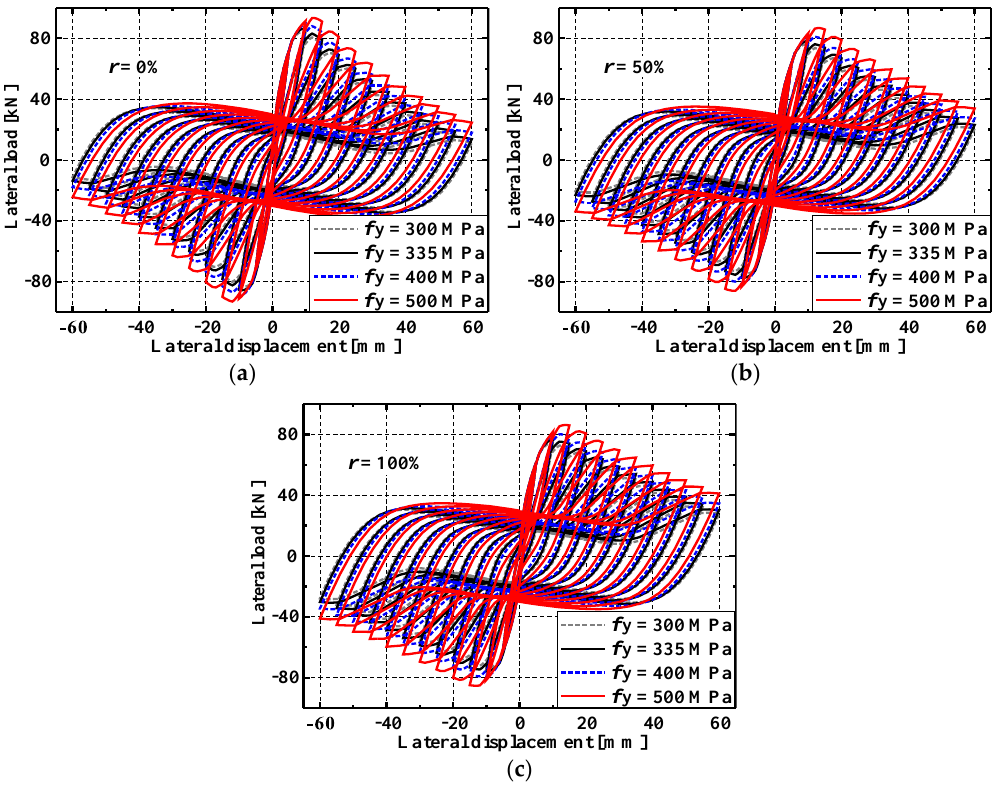
Figure 10. Effect of steel yield strength on hysteresis loops of RRC columns ( n = 0.3). ( a ) r = 0%, ( b ) r = 50%, and ( c ) r = 100%.